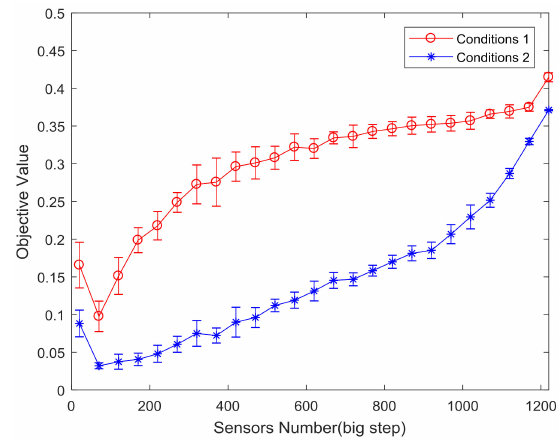
Figure 7. Average curve of the objective function value of Conditions 1 & 2.